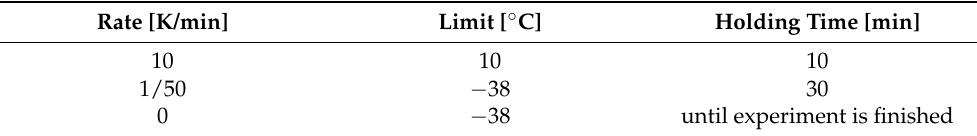
Table 1. Temperature rate and limit for the freeze-drying cycle with the used holding time. Rate [K/min] Limit [ ◦ C] Holding Time [min] 10 10 10 1/50 − 38 30 0 − 38 until experiment is finished